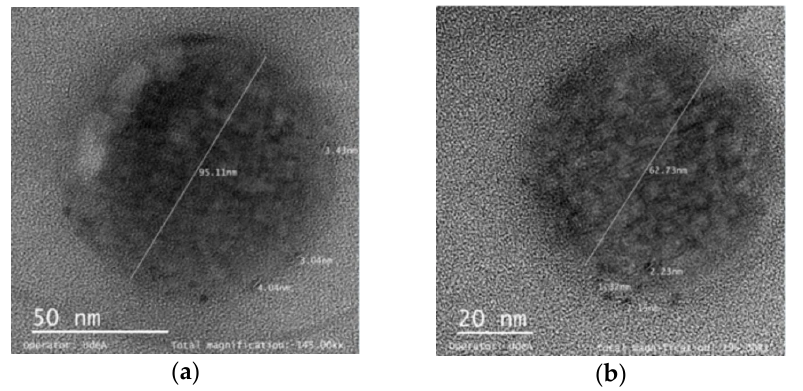
Figure 10. TEM micrographs of magnetoliposomes (MLPs). ( a ) MLPs obtained by the passive method; ( b ) MLPs obtained by the acoustic method.